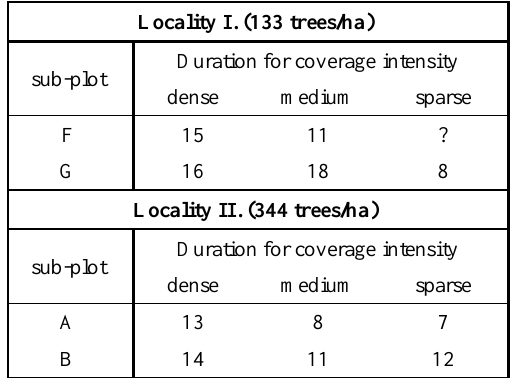
Table 2. Comparison of data acquisition duration at research